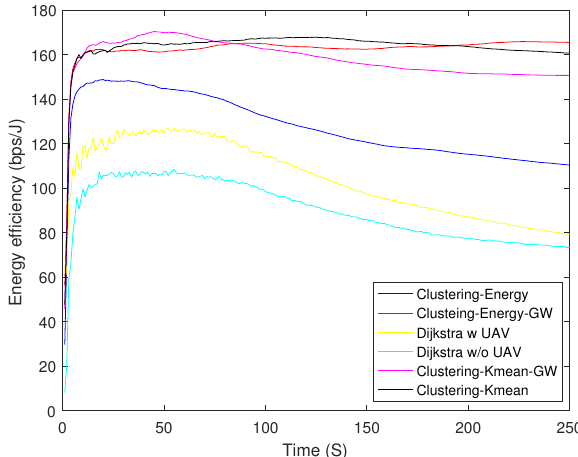
Figure 8. Energy efficiency.